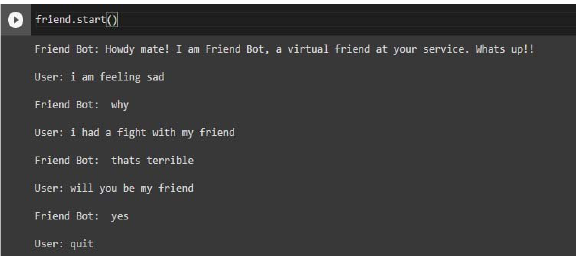
Fig 5 . Output of SVM model